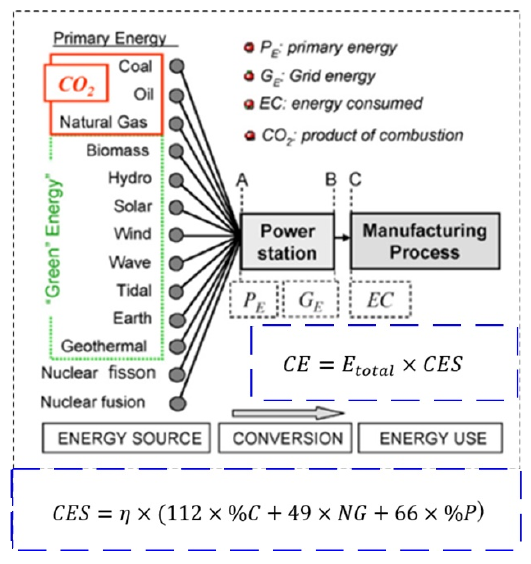
Figure 3. Primary energy supplies available [31]. Table 3. The energy produced by various types of